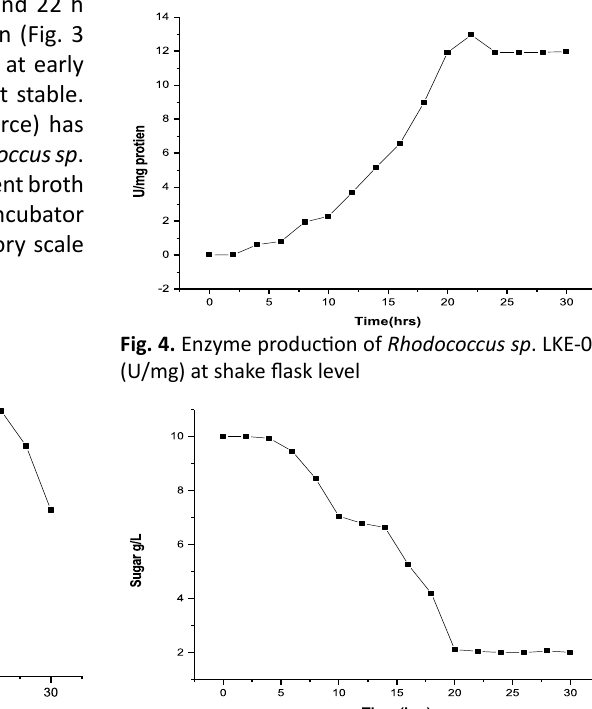
Fig. 3. Growth curve of Rhodococcus sp . LKE-021 (O.D. at 600 nm) at shake flask level